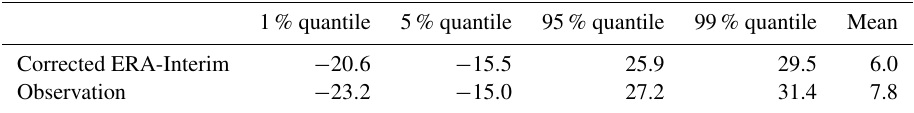
Table 6. Climatology of the entire CTM based on corrected ERA-Interim temperatures (1km, 6-hourly, 1979–2016) and daily observations (daily, 1979–2013, ◦